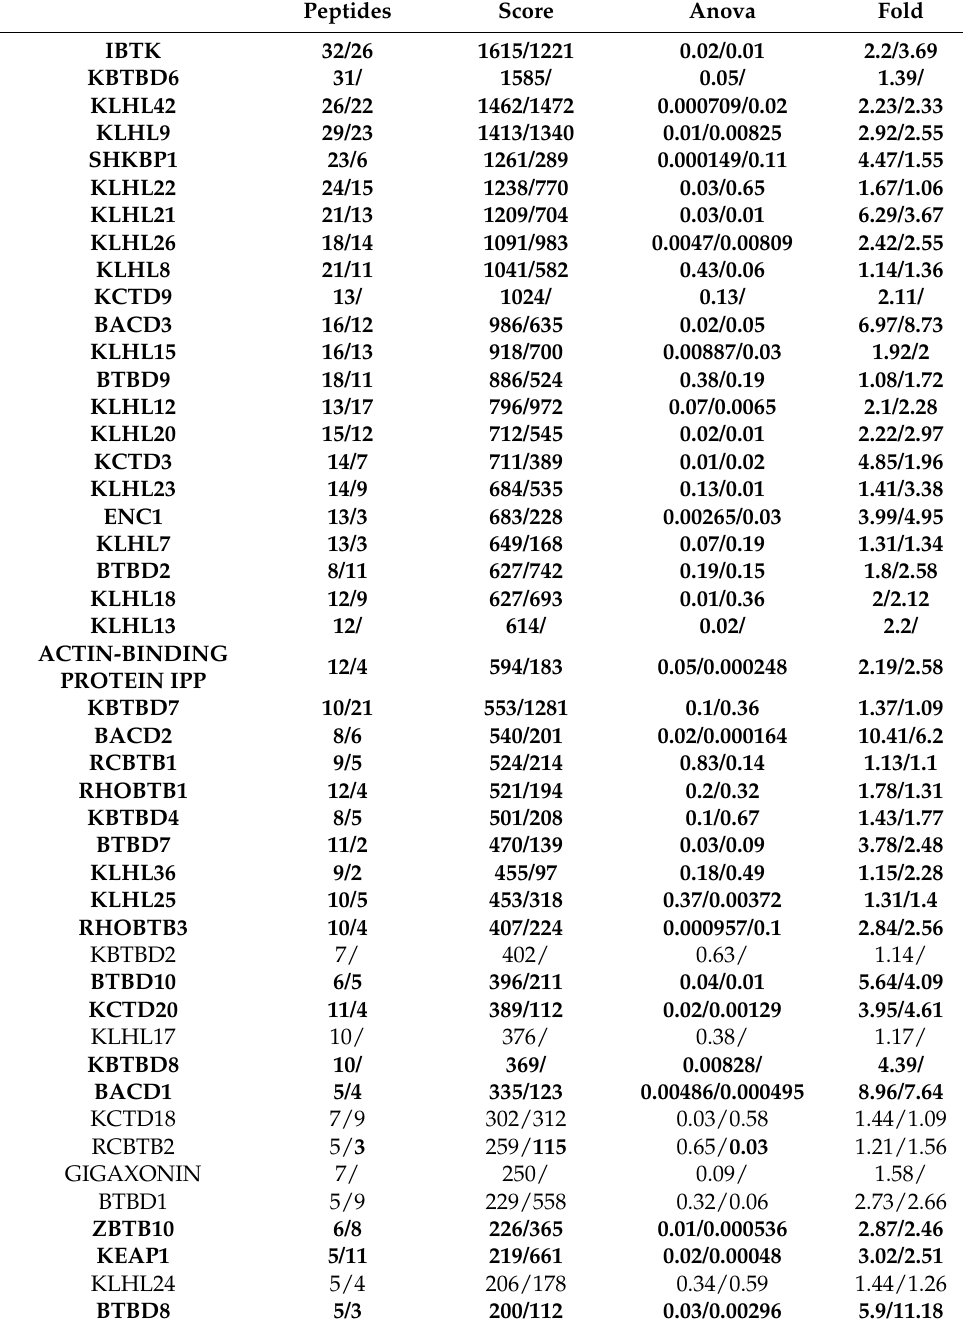
On the left a scatter plot of the results obtained for 4–5 experiments is presented. The results are expressed as the percentage of the maximal ratio of immunoprecipitated CUL3/CSN4 (C) or CUL3/CAND1 (D) normalized on the CUL3/GAPDH ratio observed on the input gel. This ratio is significantly higher for CUL3-WT compared to CUL3- ∆ 9 for both CSN4 and CAND1, independently of the neddylation state. Statistical comparisons used the Kruskal–Wallis test (* = p < 0.05 and ** = p < 0.01). Table 1. BTB-domain proteins interact more with CUL3- ∆